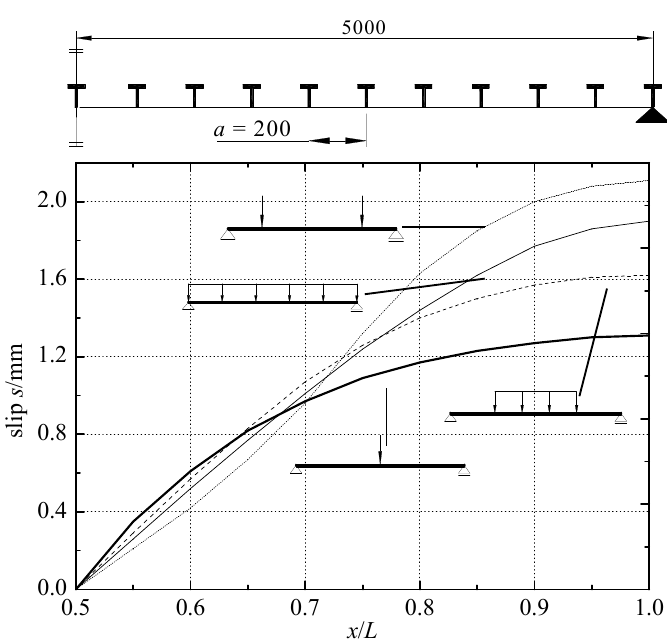
Figure 6. Shear force and moment diagram of four load cases.